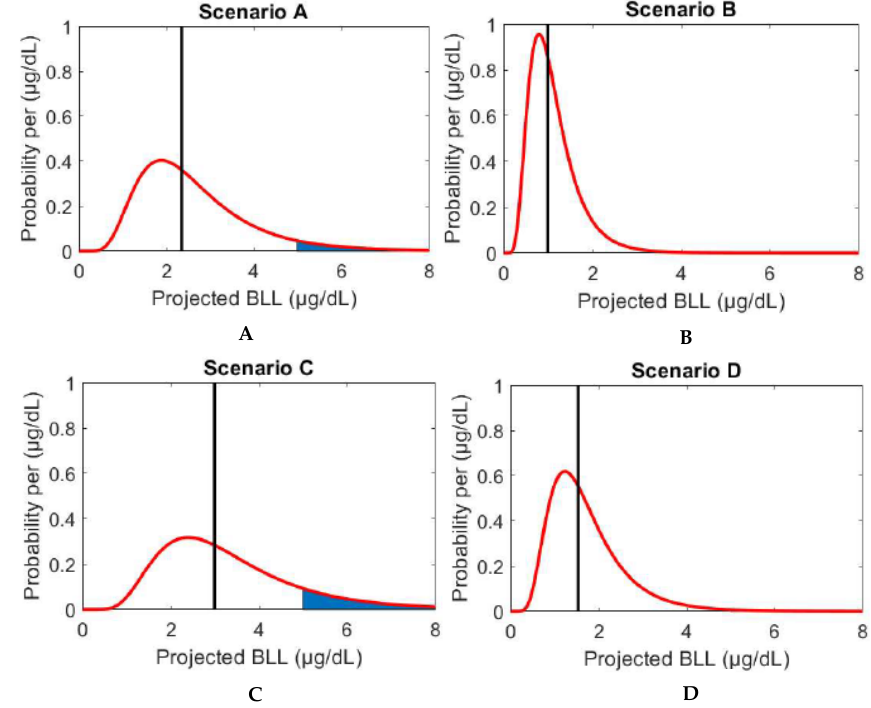
Figure 7. ( A–D ). Probability density functions and geometric means for ( A ) Scenario A, ( B ) Scenario B, ( C ) Scenario C, ( D ) Scenario D. The plots represent the distribution of projected BLLs for (A & B) elementary school students using the IEUBK model and (C & D) secondary school students using Bowers’ model. Models of scenarios A & C employed the region’s 90th percentile soil lead concentration whereas models of scenarios B & D used the median soil lead concentration. The vertical line on each figure depicts the geometric mean of the